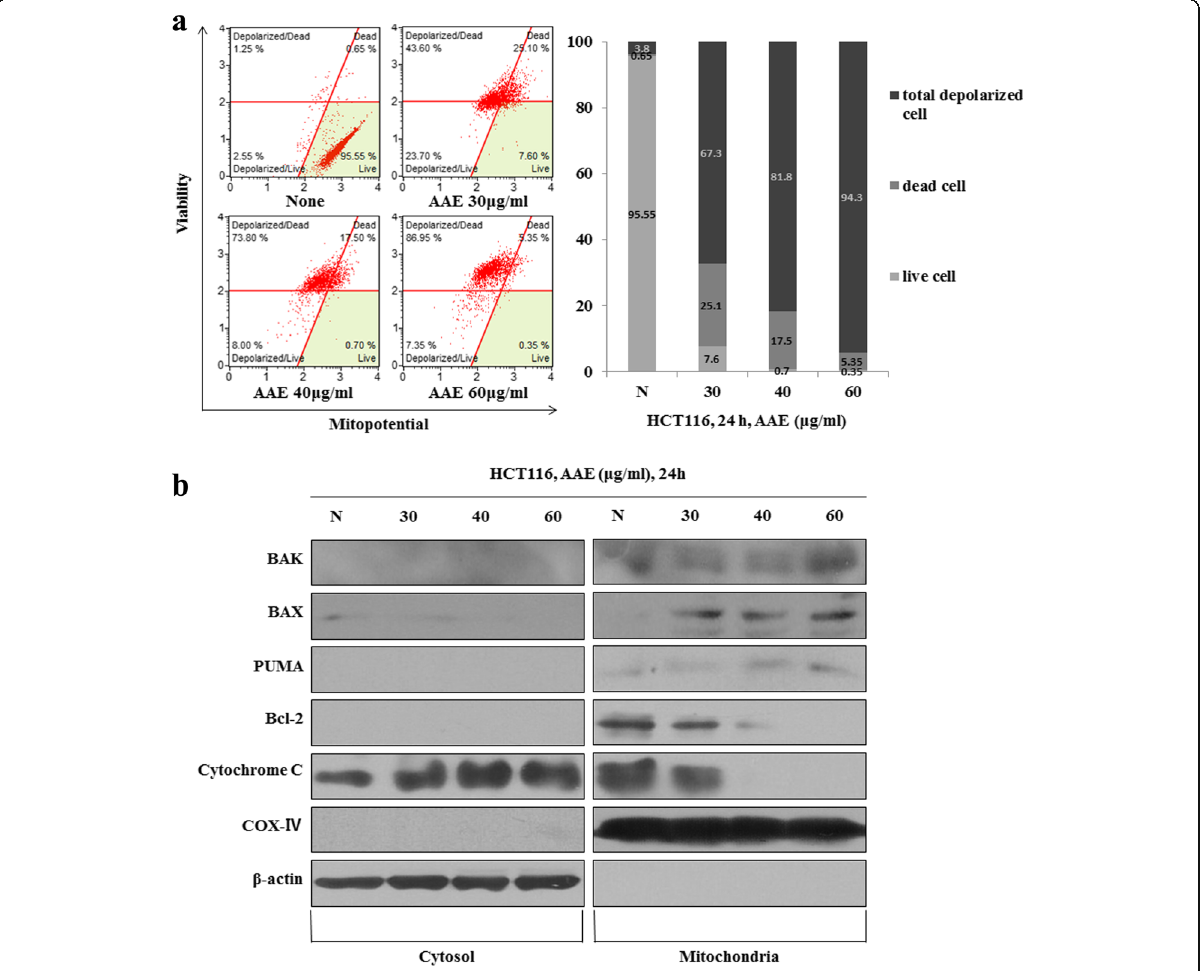
Fig. 3 AAE reduces the mitochondrial membrane potential. a Mitochondria membrane potential were evaluated by Muse ™ Mitopotential kit. Cells were treated with different concentration of AAE (HCT116 were treated with 0, 30, 40, and 60 ìg/ml of AAE) for 24 h. b Fraction of mitochondria/ cytosol protein levels were analyzed by Western